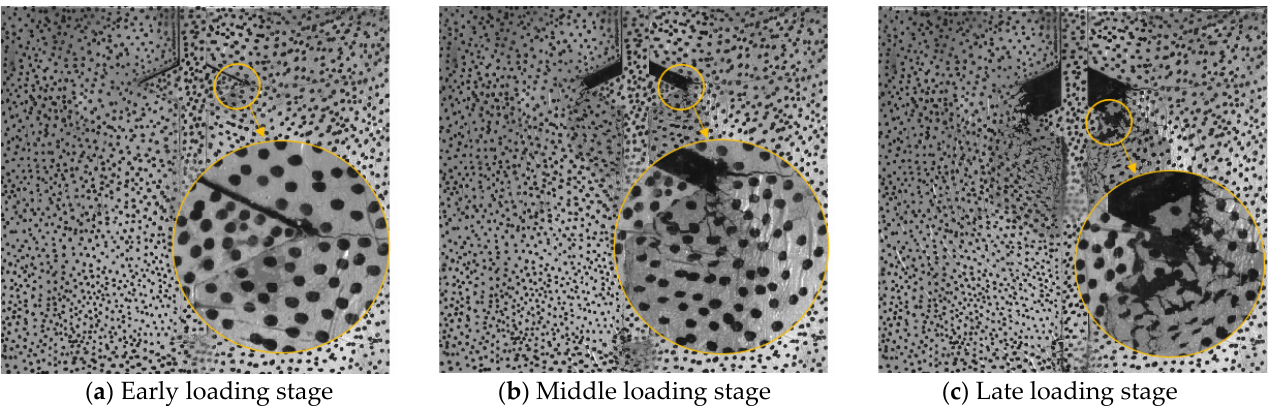
Figure 5. Failure process of soil surrounding the pile.